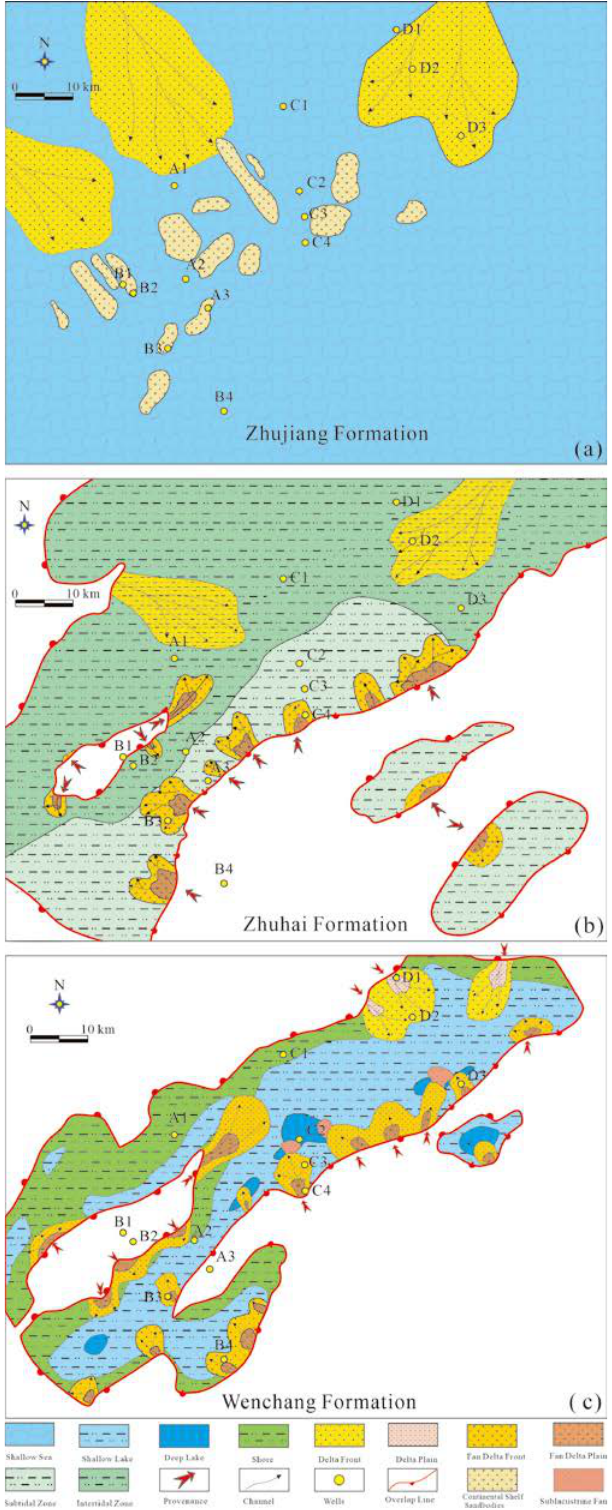
Figure 6. Deposition facies diagrams of the Zhujiang Formation ( a ), Zhuhai Formation ( b ), and Wenchang Formation ( c ) of the Zhu III Depression, PRMB, showing the depositional evolution from the Eocene Wenchang Formation to the Miocene Zhujiang Formation.